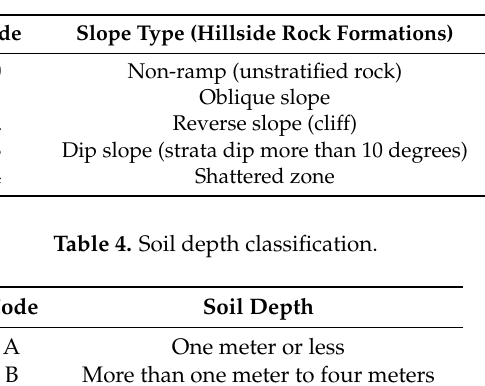
Table 3. Hillside rock structure classification.